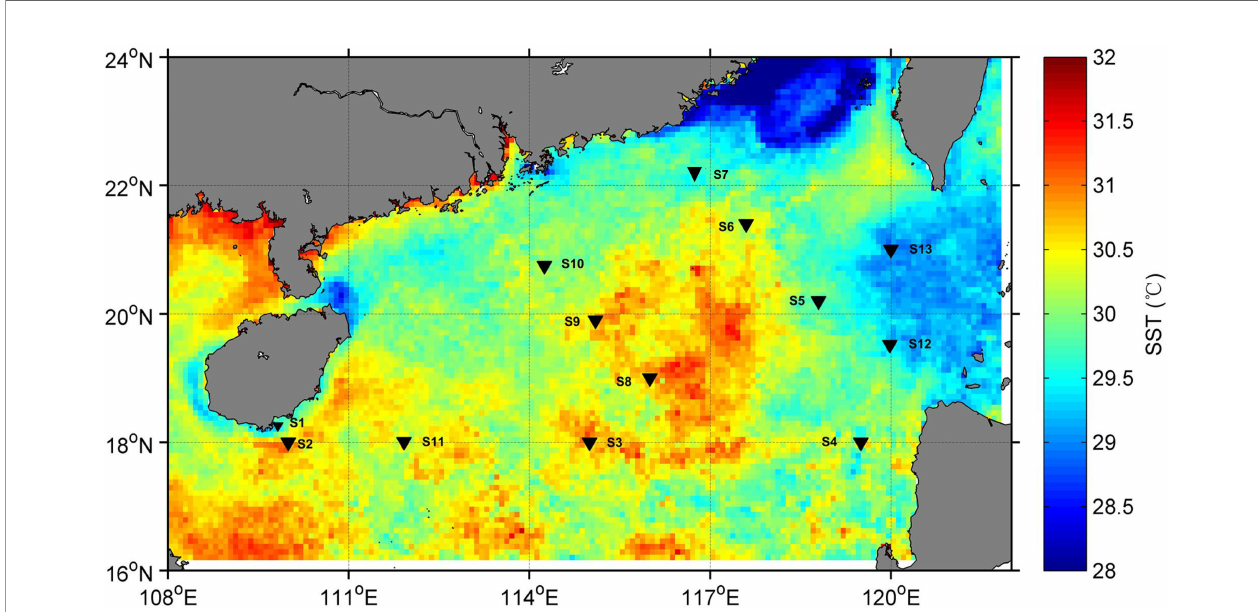
FIGURE 1 | Map of sampling stations in the South China Sea. Sea surface temperature (SST) during investigation time was shown in the base map that was obtained from